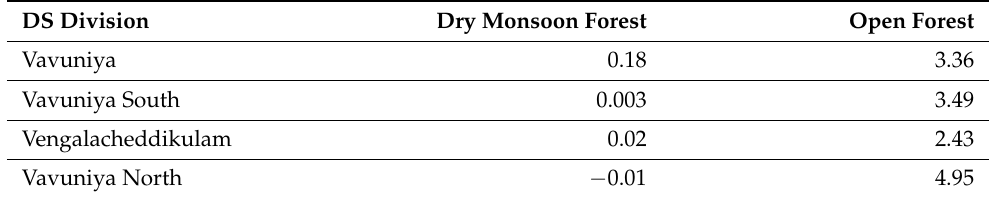
Table 5. Annual rates of dry monsoon and open forest cover changes, from 2001–2020, by DS division. DS